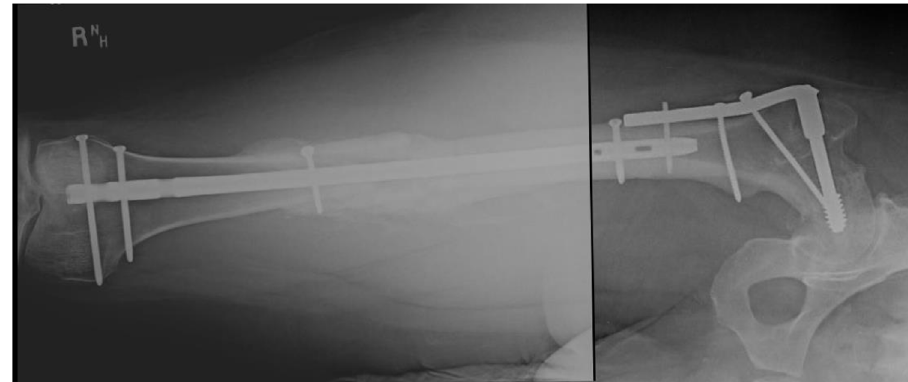
Figure 2. Healed fracture with no symptoms of leg length